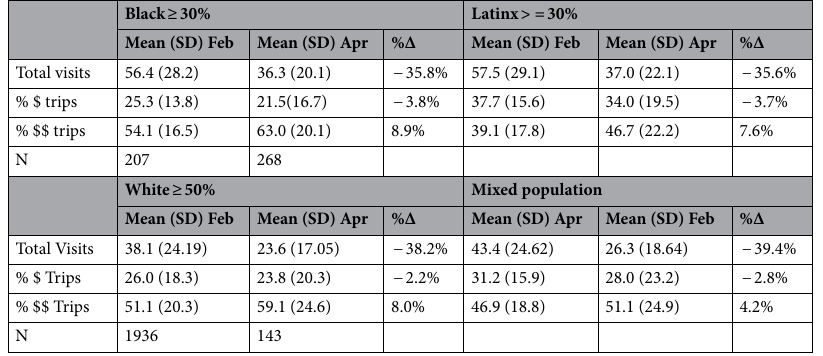
with large Latinx populations and Mixed Population (i.e., not reaching any of the stated thresholds) saw less prioritization of two-dollar sign stores (Δ = 7.6% and 4.2%, respectively). Who changed their visitation patterns? Various community features predicted the extent to which communities lessened their visits to grocery stores (see Methods for more detail on specification and Table 2 for main results; full models control for population size and pre-pandemic versions of the outcome measure, thereby enabling an interpretation of how other variables affected shifts in grocery store visitation; all parameters reported in SI). Communities with a higher proportion of Black and Latinx residents and lower median income had more visits than expected (% Black: B = 0.05, p < 0.001); % Latinx: B = 0.05, p < 0.001; income: B = − 0.12, p < 0.001). These relationships were independent of the number of grocery stores within a 15-min drive, which was a non-significant predictor. Communities also differed in their tendency to shift toward two-dollar-sign stores. Those with a higher percentage of Black residents especially prioritized two-dollar-sign stores (relative to predominantly White communities; B = 2.73, p < 0.001), whereas communities with a higher proportion of Latinx residents marginally did the reverse (B = − 1.16, p < 0.10). Communities with higher median incomes also prioritized two-dollar-sign stores (B = 1.49, p < 0.05). These results were independent of the number of two-dollar-sign stores within a 15-min drive, which was non-significant. To better understand what trips to two-dollar-sign stores replaced (or were replaced by) across communities, we replicated the analysis for one-dollar-sign stores. Here we see that communities with more Latinx residents and, to a lesser extent, those with more Asian residents, made a greater proportion of their visits than expected to one-dollar-sign stores (% Latinx: B = 2.55, p < 0.001; % Asian: B = 1.05, p < 0.05), whereas communities with more Black residents and higher median incomes moved away from such stores (% Black: B = − 1.02, p < 0.05;